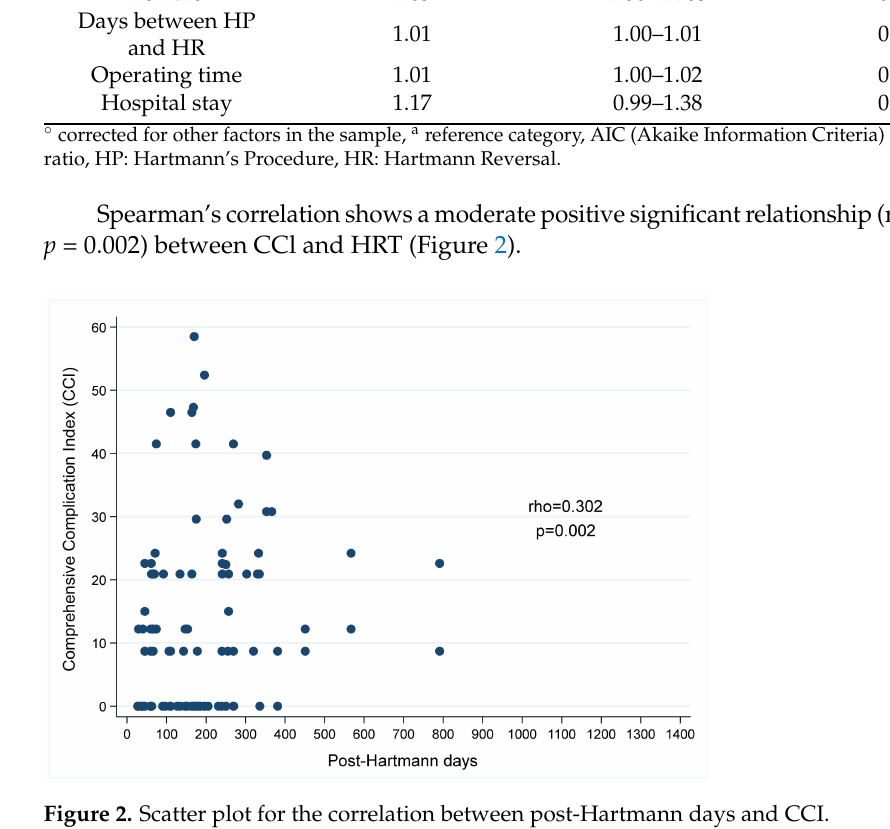
Figure 2. Scatter plot for the correlation between post-Hartmann days and